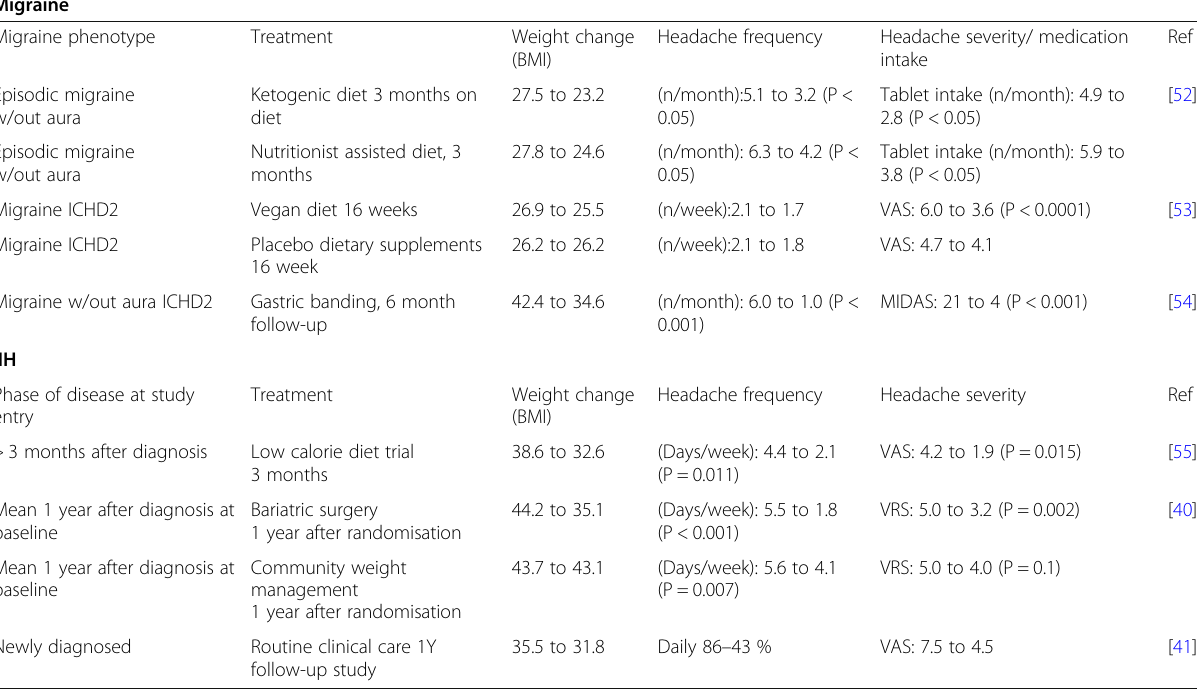
Table 1 Weight loss treatments and effects on headache in migraine and IIH. Data presented depicts means before and